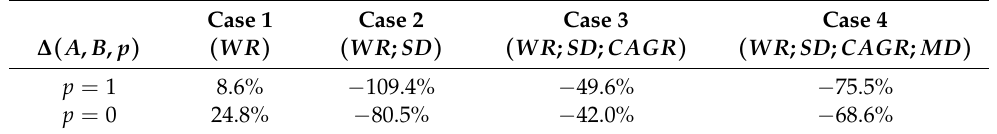
Table 2. EMH test SPDR EURO STOXX 50 ETF versus EURO STOXX 50.